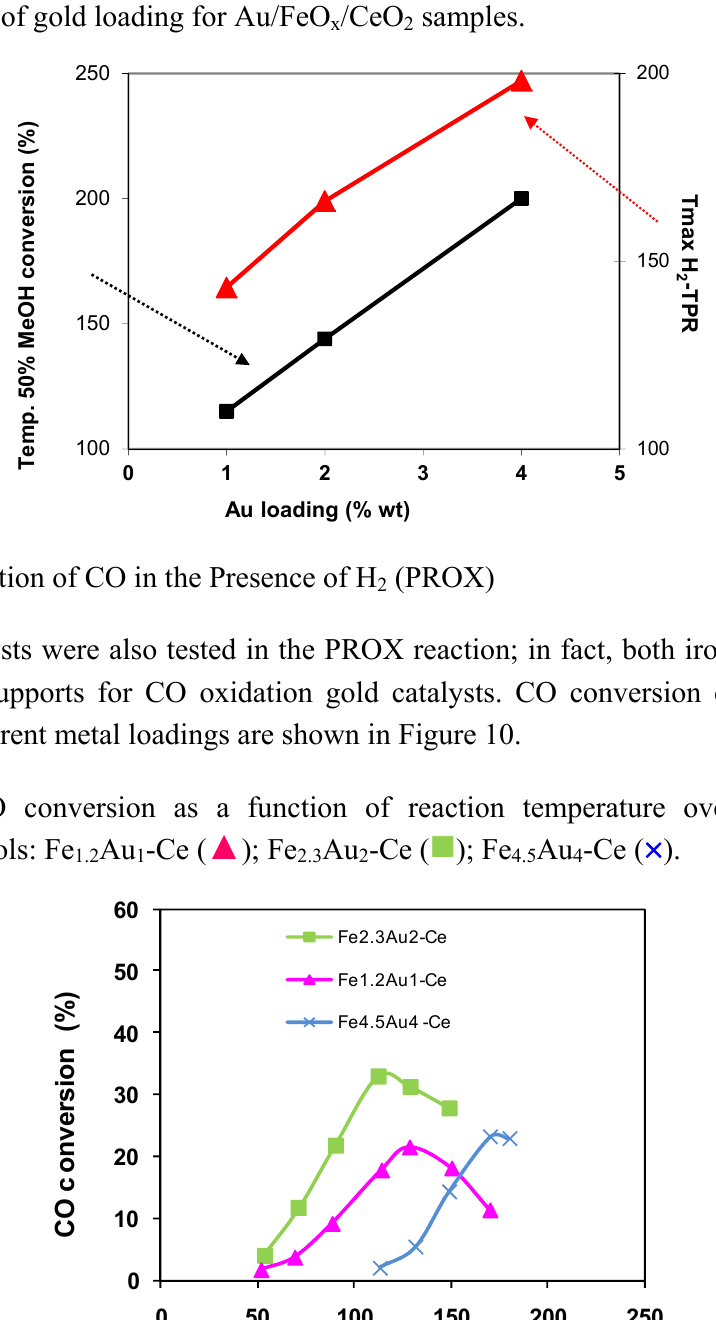
Figure 9. Temperature of 50% methanol conversion ( ■ ) and Tmax of the reduction peak ( ▲ ) in function of gold loading for Au/FeO